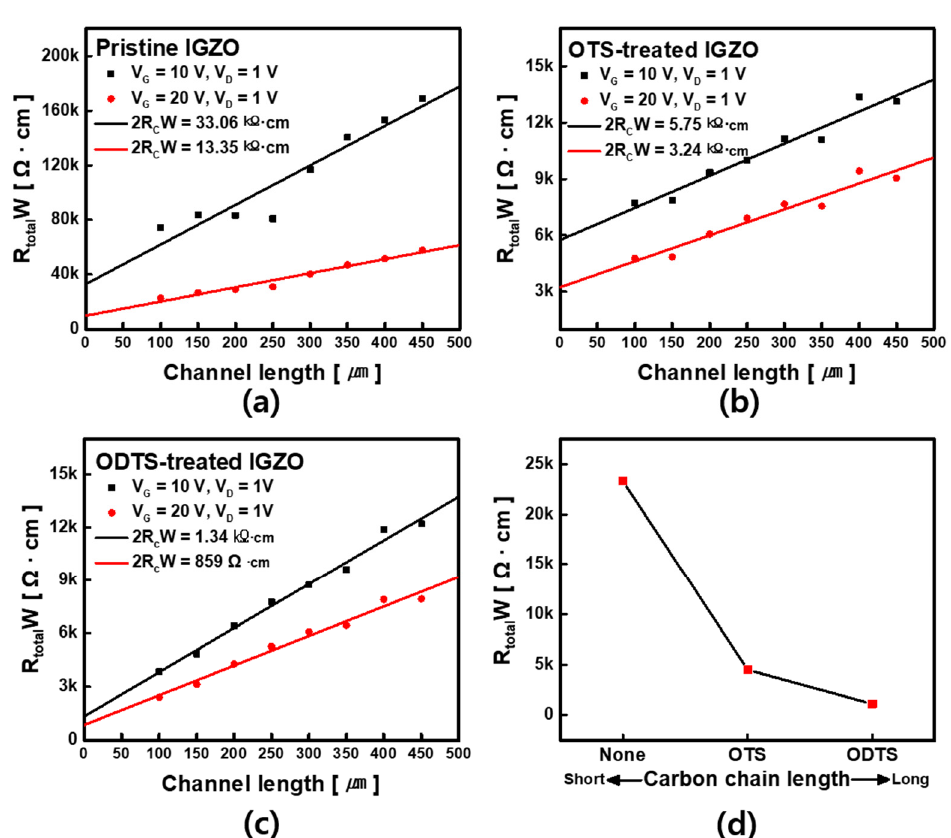
Figure 5. Contact resistance graph of pristine ( a ), OTS-treated ( b ) and ODTS-treated transistors; ( c , d ) Influence between length of carbon chain and contact resistance.